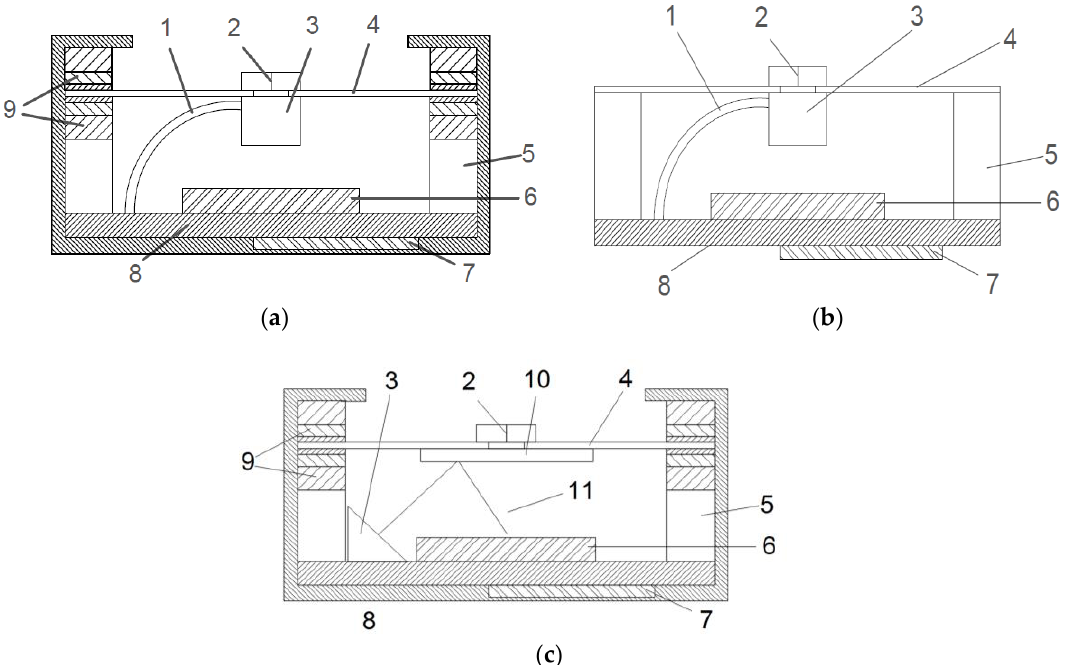
Figure 2. ( a ) The 3-axis sensor, version 1; ( b ) The 3-axis sensor, version 2; ( c ) The 3-axis sensor, version 4. The 3-axis sensor consists of the following components: